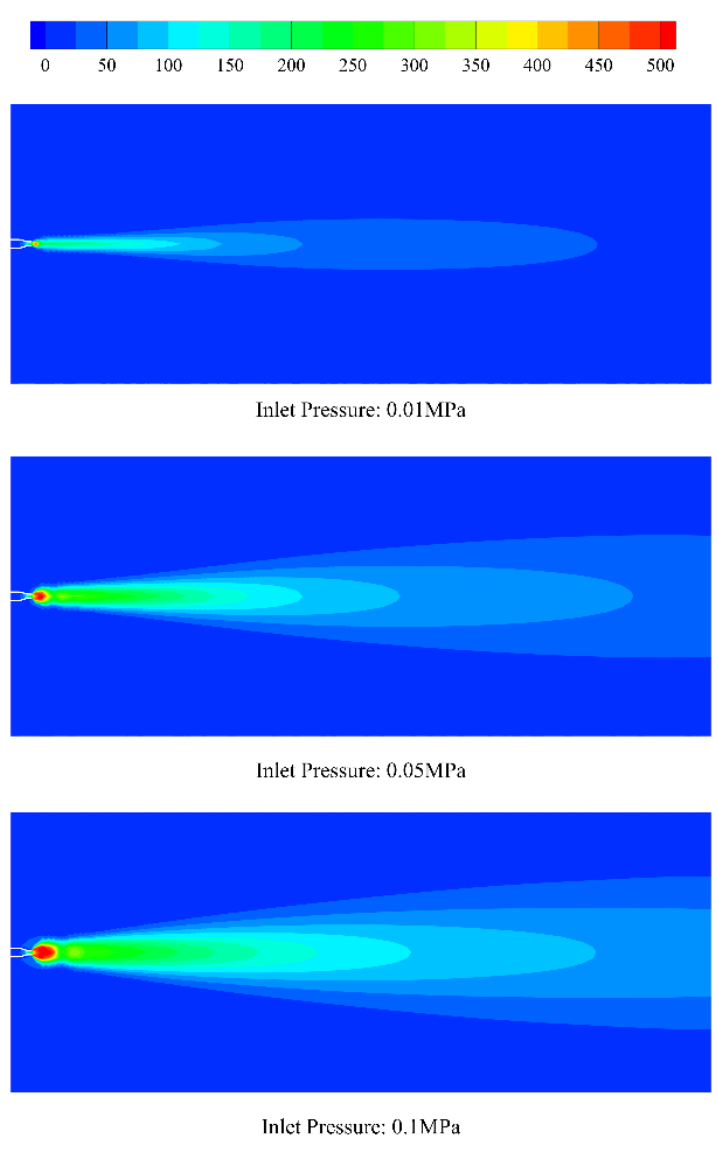
Figure 2. Velocity contours of nozzle #1 at different inlet pressures (m/s).